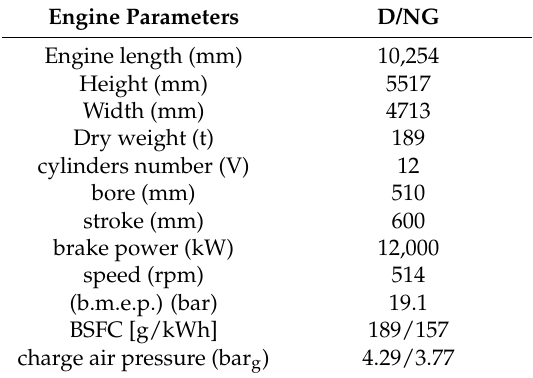
Table 1. MAN 51/60 DF 12V engine main dimensions and design (MCR)